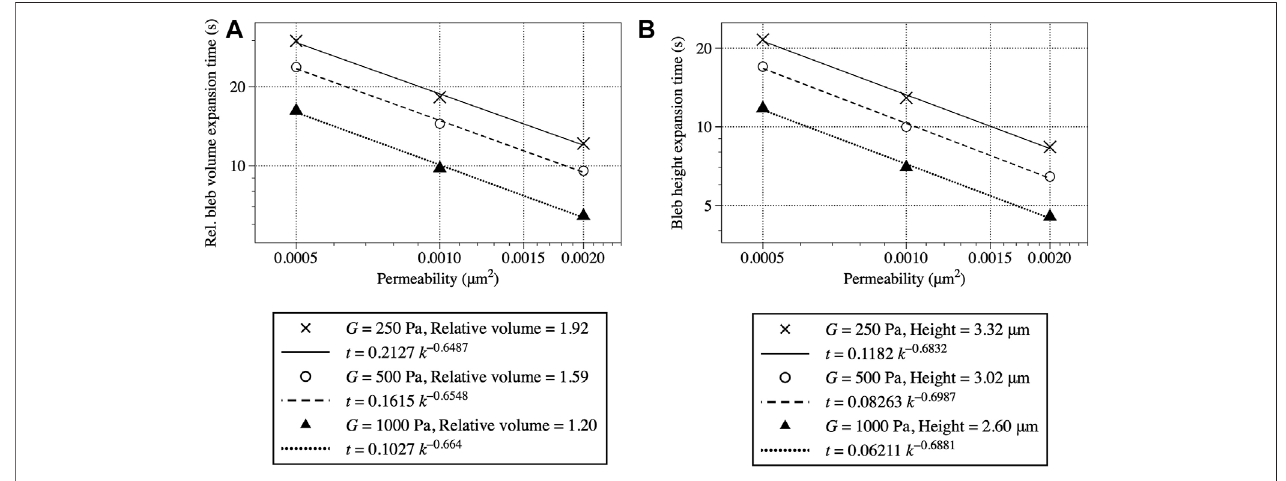
FIGURE 8 | Bleb expansion time in seconds as a function of cytoplasmic bulk modulus G and permeability κ . Bleb expansion is computed using relative bleb volume in (A) and bleb height in (B) . For both fi gures, the expansion time is 90% of the steady state value listed in the